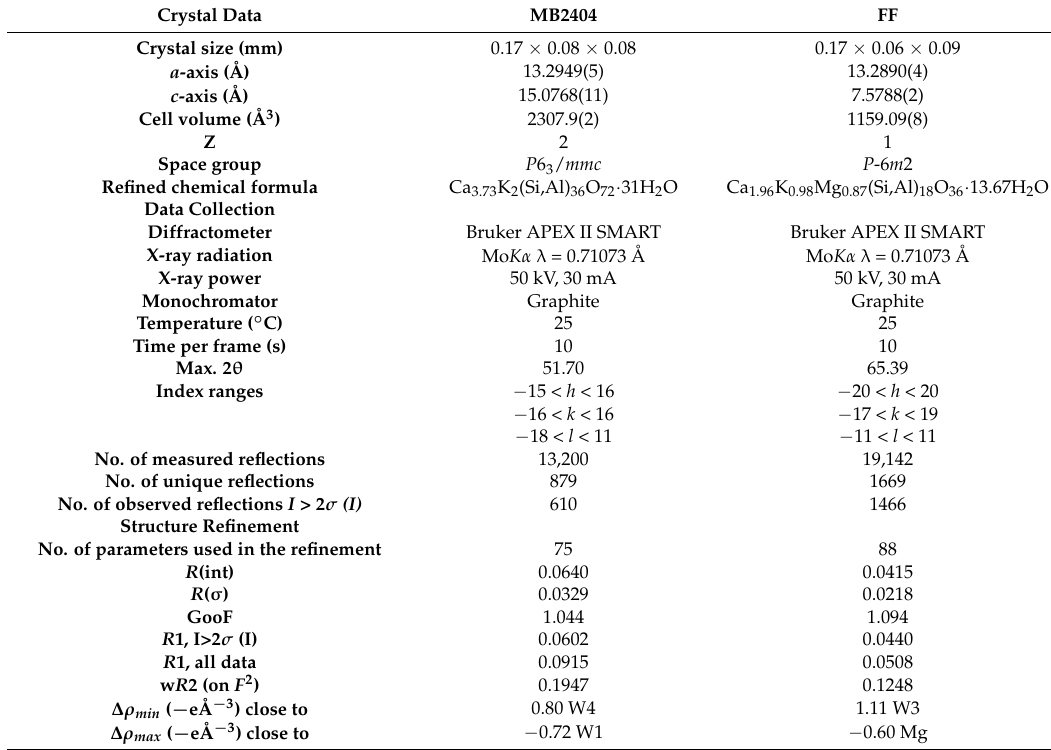
Table 2. Crystal data and refinement parameters of MB2404 erionite and FF offretite